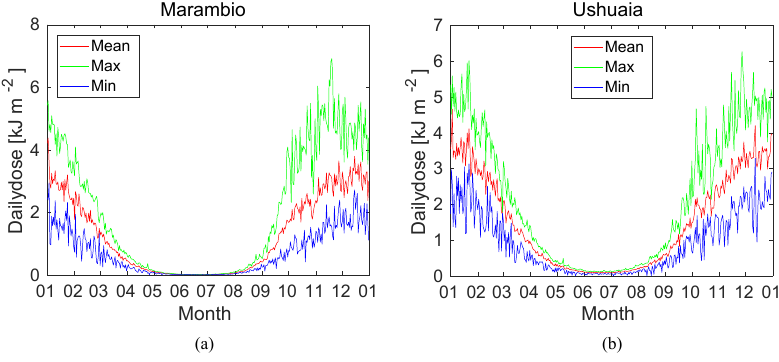
Figure 11. The mean, minimum and maximum erythemally weighted daily dose (kJm − 2 ) calculated from the respective days of each year of observations in (a) Marambio and (b) Ushuaia during